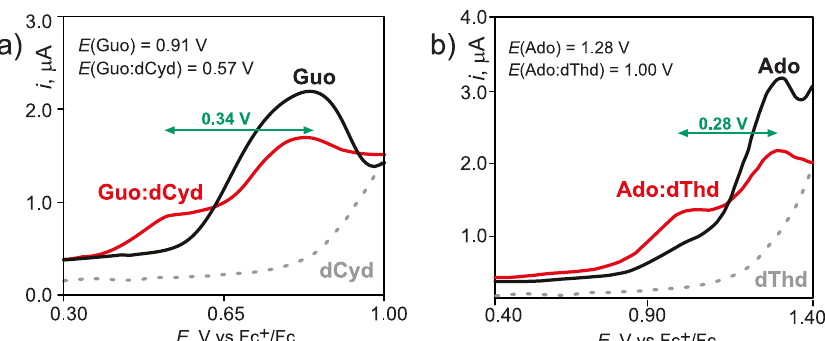
Figure 3. Differential pulse voltammograms of nucleoside derivatives in CHCl 3 at 298 K on glassy carbon electrode. ( a ) Solutions containing only Guo 2.0 mM (black line); only dCyd 2.0 mM (dashed gray line); and Guo 2.0 mM and dCyd 2.0 mM (red line). ( b ) Solutions containing only Ado 2.0 mM (black line); only dThd 2.0 mM (dashed gray line); and Ado 2.0 mM and dThd 20.0 mM (red line). Scan rate, 100 mV/s. Supporting electrolyte Bu 4 NClO 4 . Oxidation potentials are referred to the Ferrocenium/Ferrocene (Fc + /Fc) redox couple. Green arrows indicate the lowering of the oxidation potential of purine nucleosides upon pairing via H-bond with their complementary pyrimidine nucleosides. Adapted with permission from J. Am. Chem. Soc. 2005 , 127 , 15040–15041 and J. Am. Chem. Soc. 2007 , 129 , 15347–15353. Copyright (2005, 2007) American Chemical